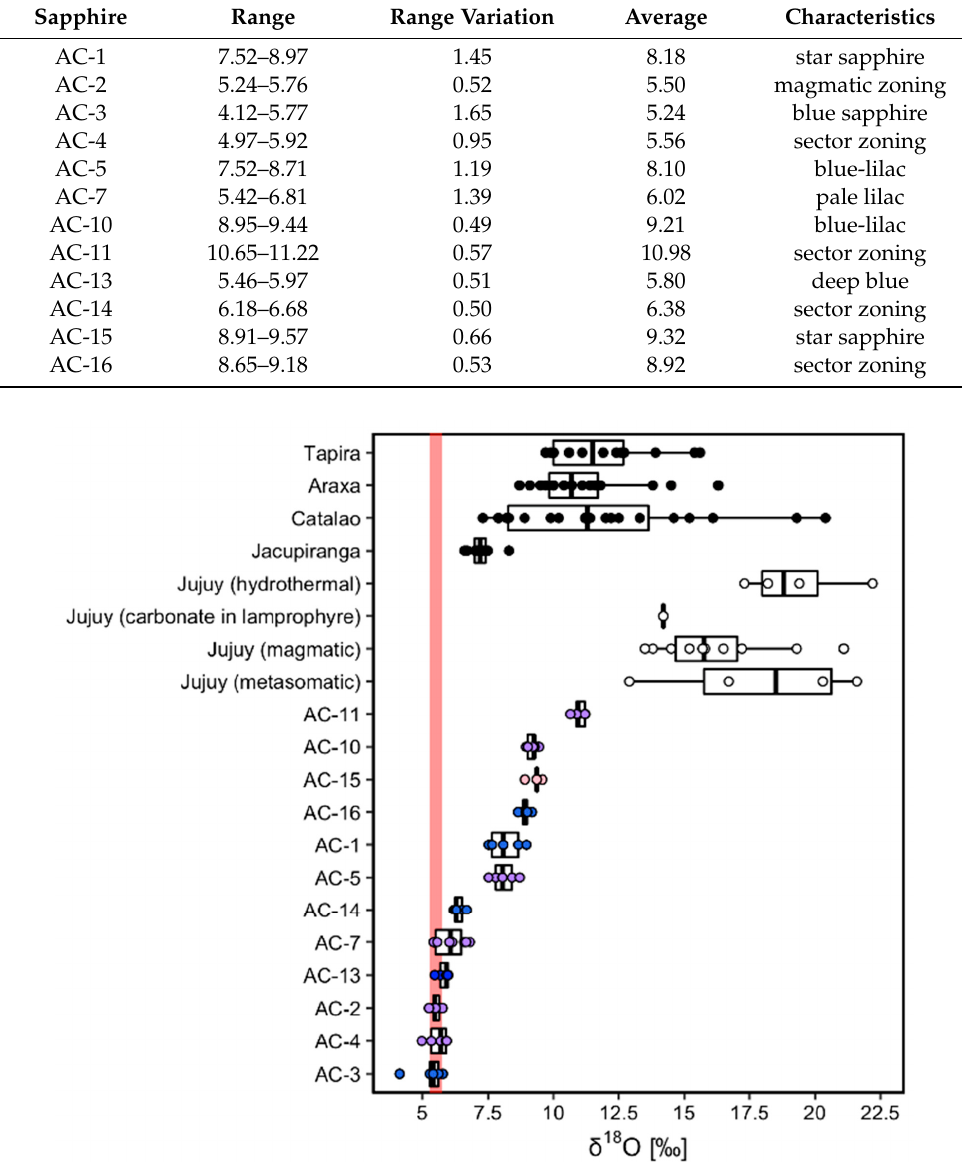
Table 3. Summary of δ 18 O results for the 12 samples analyzed.